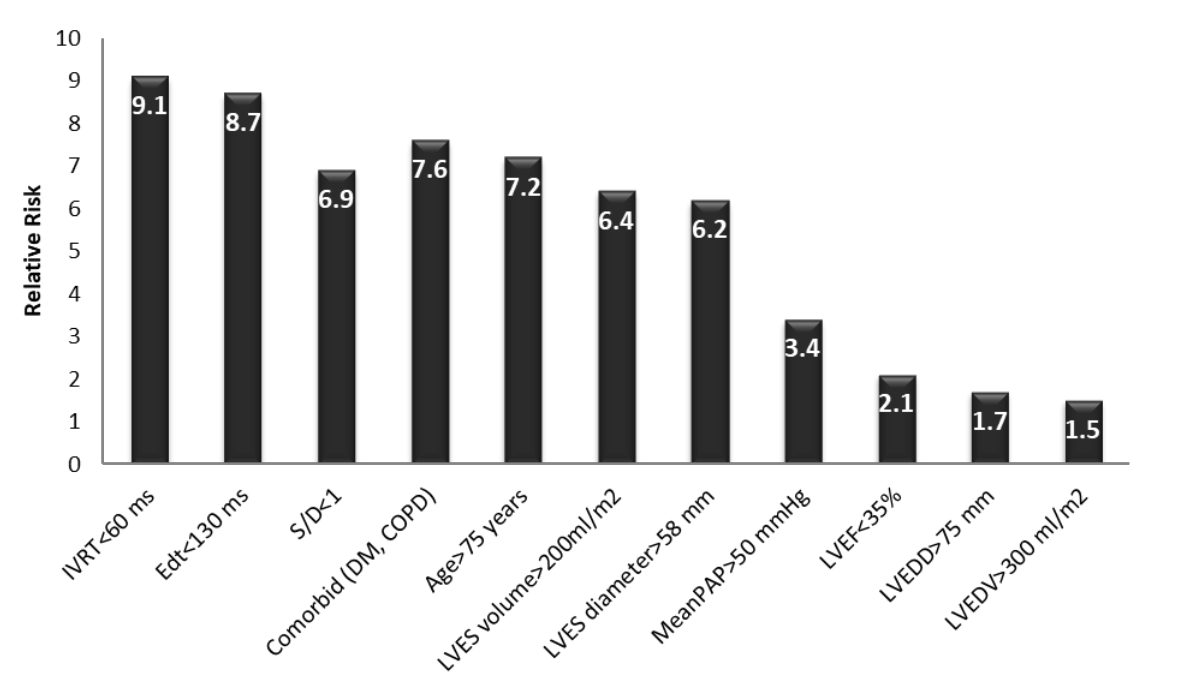
Figure 3. Early postoperative risk of death in patients with aortic regurgitation undergoing AVR. IVRT—isovolumetric relaxation time; DM—diabetes mellitus; COPD—chronic obstructive pulmonary disease; LVES—left ventricle end-systolic; PAP—pulmonary arterial pressure; LVEF—left ventricle ejection fraction; LVEDD—left ventricle end-diastolic diameter; LVEDV—left ventricle end-diastolic volume.